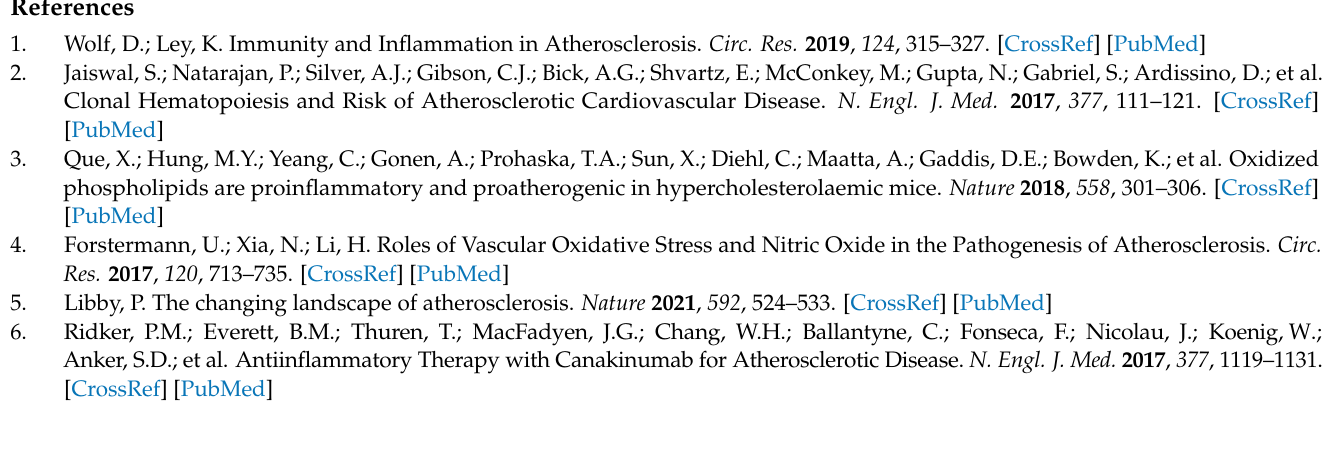
Table S2: Up regulated -chipseq_rnaseq_overlap_genes. Table S3: Atox1_GO_BP pathway. Table